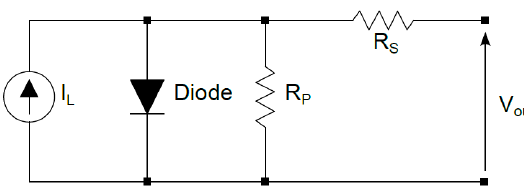
Figure 4. Photovoltaic harvester equivalent circuit.